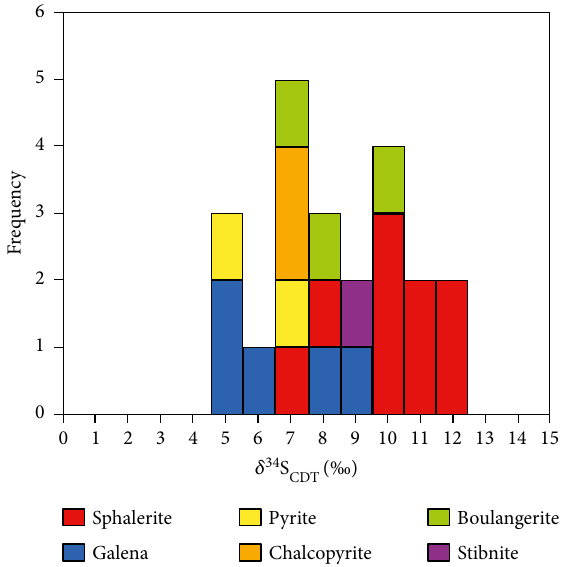
Figure 11: Frequency histogram plots of δ 34 S values for sul fi de minerals from the Keyue Sb – Pb – Zn – Ag